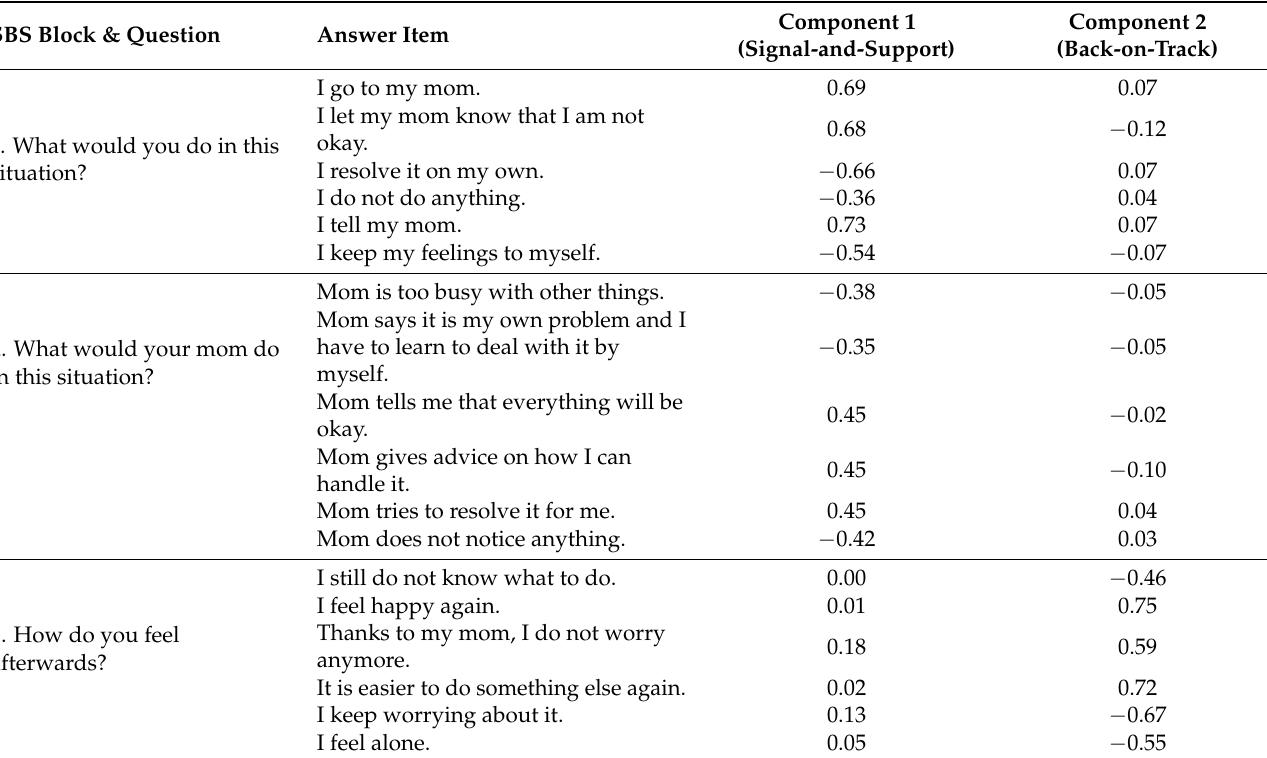
Table 2. Normalized SCA-P